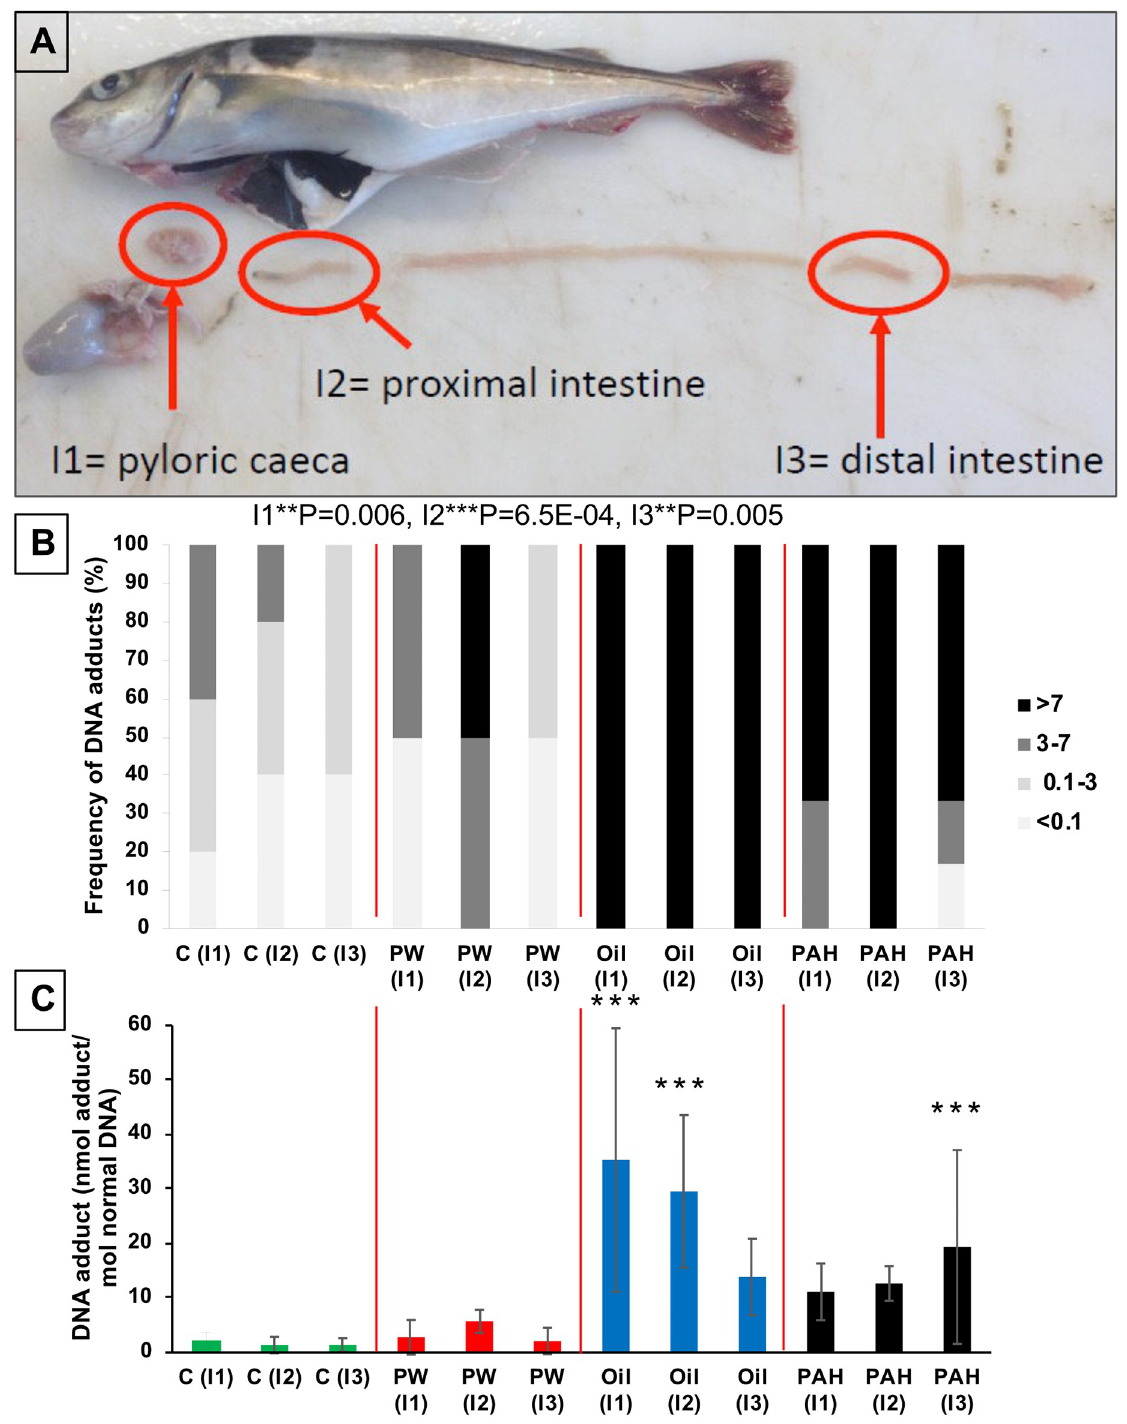
Fig 9. DNA adducts in the intestine system of fish from the different treatments groups after 67 day of oral exposure to three exposure feeds; produced water ( PW , n = 4)), oil fraction ( Oil , n = 4) and heavy PAH mixture ( PAH , n = 6) and a clean control feed (C, n = 5). Samples from different parts of the intestine were taken at 3 different positions (A). (B) The frequency (%) of DNA-adducts divided into four intervals (below detection limit; < 0.1 nmol DNA adduct/mol normal DNA, 0.1–3 nmol DNA adduct/mol normal DNA, 3–7 nmol DNA adduct/mol normal DNA, > 7 nmol DNA adduct/mol normal DNA. Asterisks indicate statistical difference in the relative distribution between the treatment groups (Fisher Exact Contingency Table analysis). P < 0.01 = �� , P < 0.001 = ��� . (C) the average levels of DNA